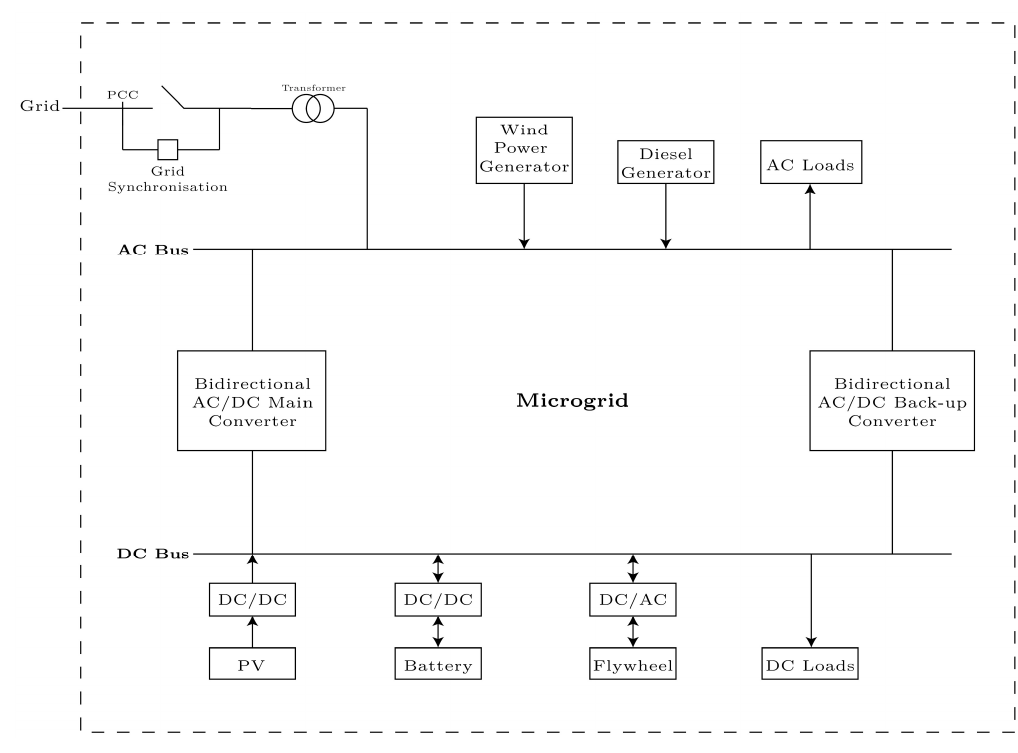
Figure 3. Hybrid microgrid structure and components example.